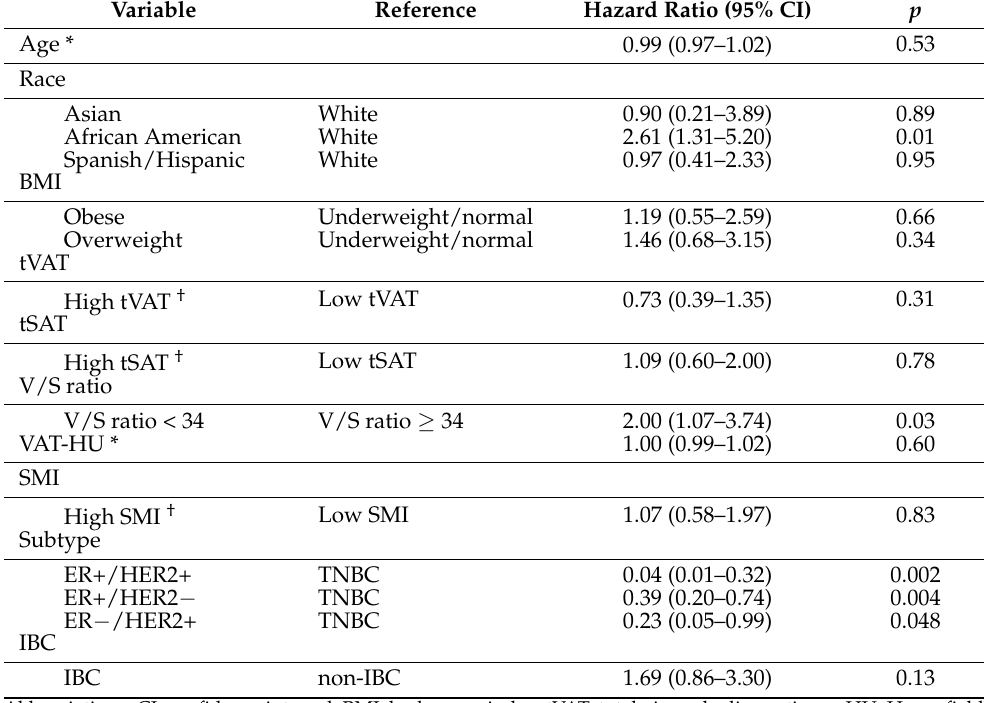
Table 2. Proportional hazards assumption for overall